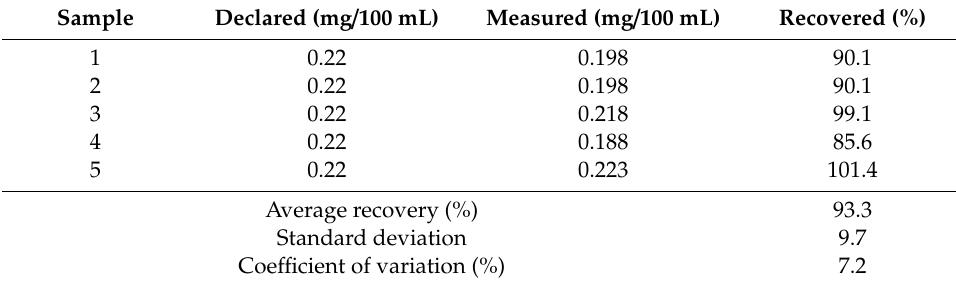
Table 5. Recovery data for vitamin B1 in a commercially available multivitamin